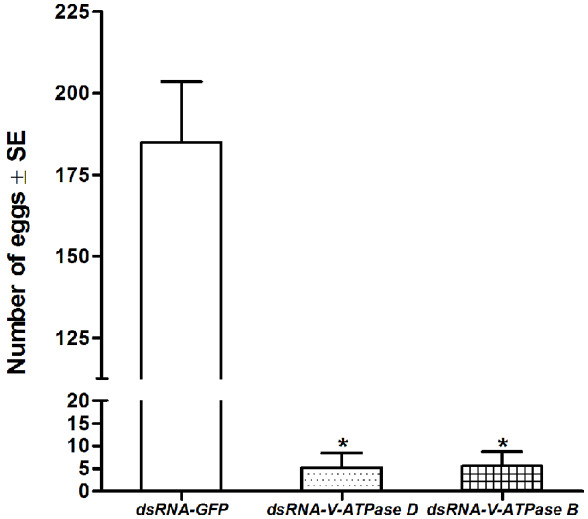
Figure 5. Fecundity of Peregrinus maidis after injection with dsRNA. Newly emerged, 24-h-old female and male planthoppers were injected with 50 nL (250 ng) dsRNA of GFP , V-ATPase B or V-ATPase D . Following injection, five replicate mating/oviposition cages were prepared per treatment with each cage containing two females and two males on a single corn plant. Seven days after injection, eggs laid in corn leaves were enumerated. Each bar represents the mean and standard error of the mean of n = two independent biological replicates of the experiment. The asterisk (*) indicates that treatment means differ significantly ( P , 0.05) from the dsRNA-GFP control